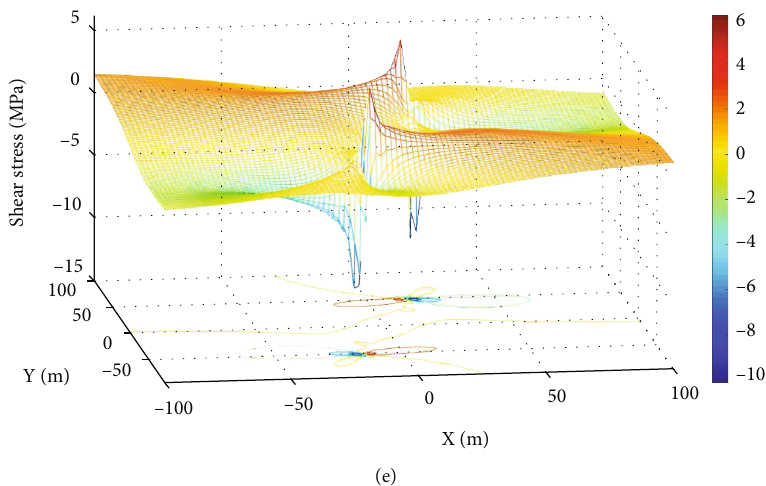
Figure 3: Hydraulic fracture morphology and induced stress fi eld: (a) initial crack location and stress model; (b) normal stress σ stress σ xy ; (d) the fl uctuation of σ xx in the simulated region; (e) the fl uctuation of σ xy in the simulated region.